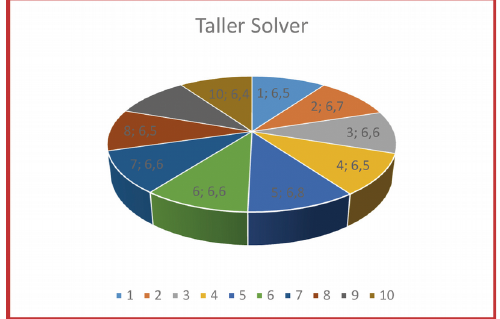
Figure 22. Solver workshop grades (Where 1; 6,7 means Student; Grade)